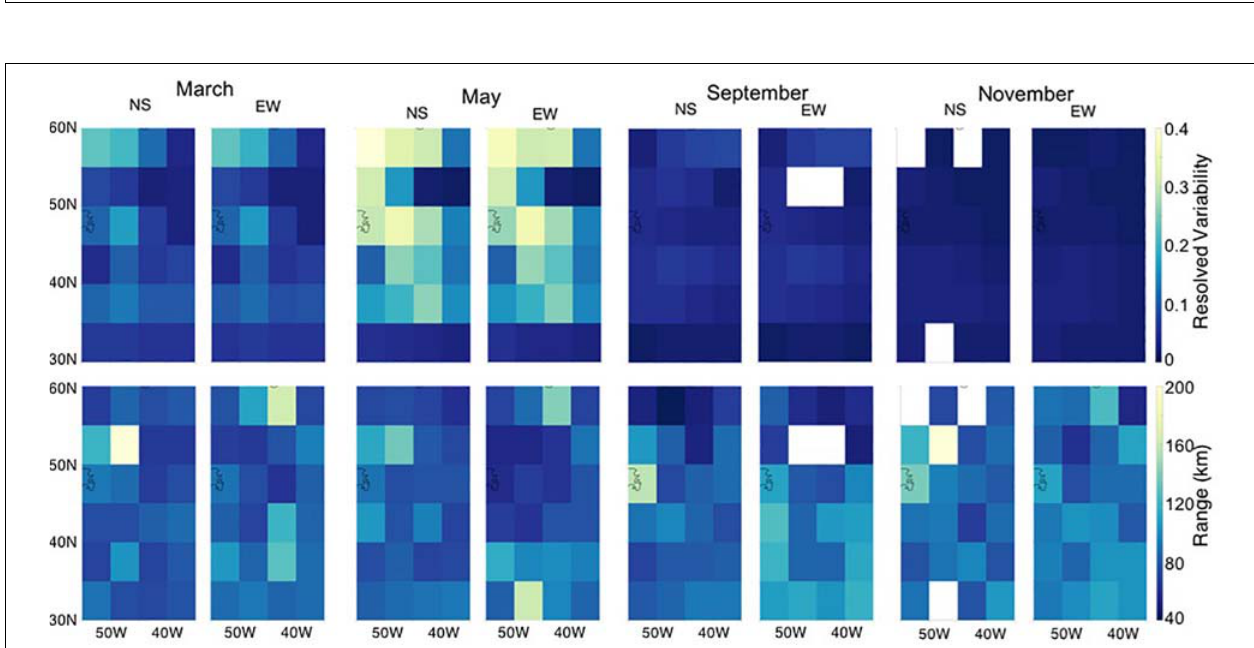
FIGURE 2 | Field measured Log 10 surface chlorophyll a concentration for the four NAAMES campaigns, organized by month. Ship-based, underway measurements shown in closed circles. Grayed rectangle indicates grid region displayed in Figures 3 , 4 .